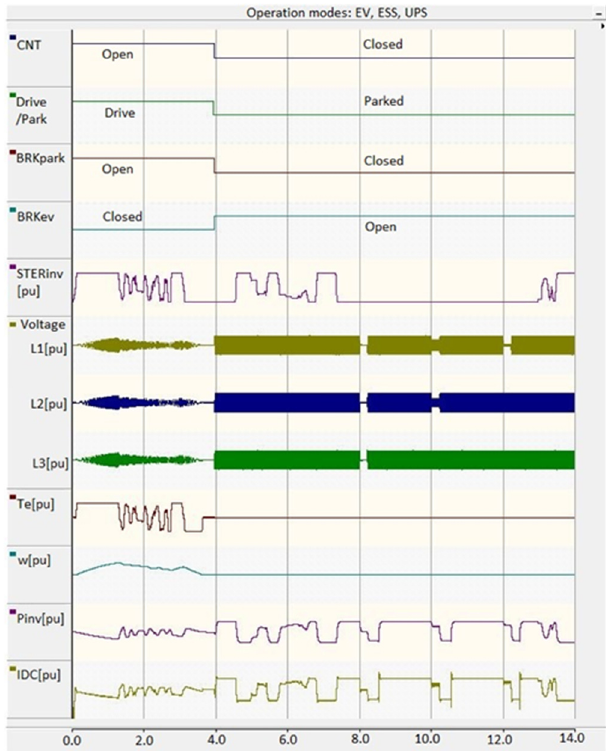
Figure 3. Main parameters describing processes during all EV operation states, breakers positions, voltages, currents, engine torque and speed.